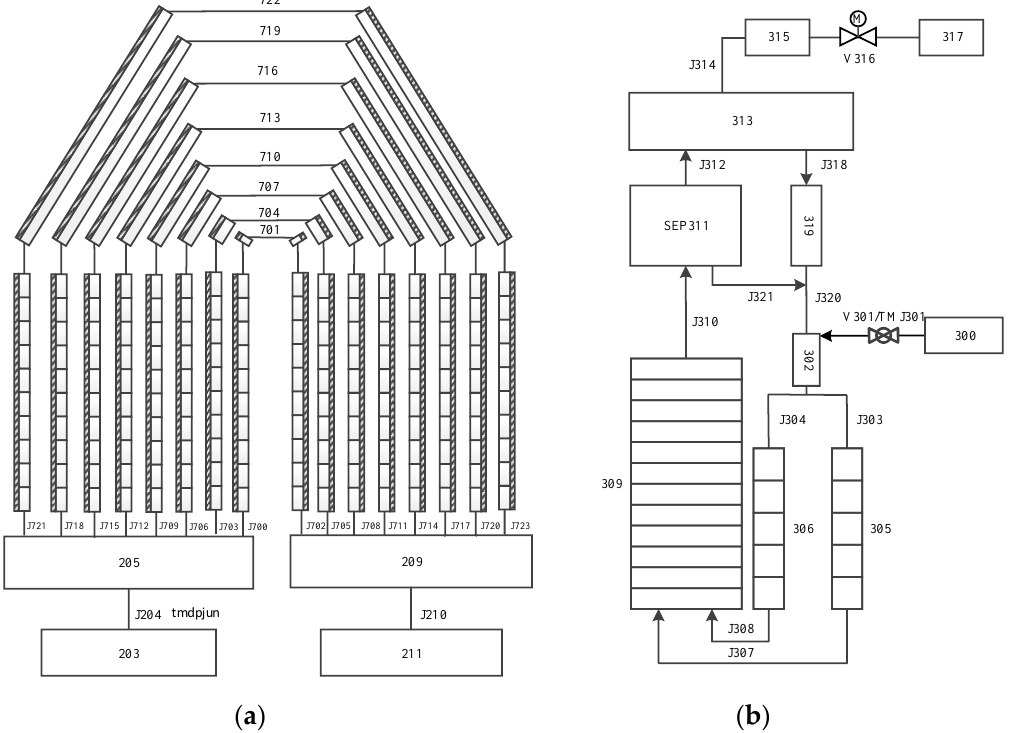
Figure 6. Nodalization scheme: ( a ) the primary loop; ( b ) the secondary loop.